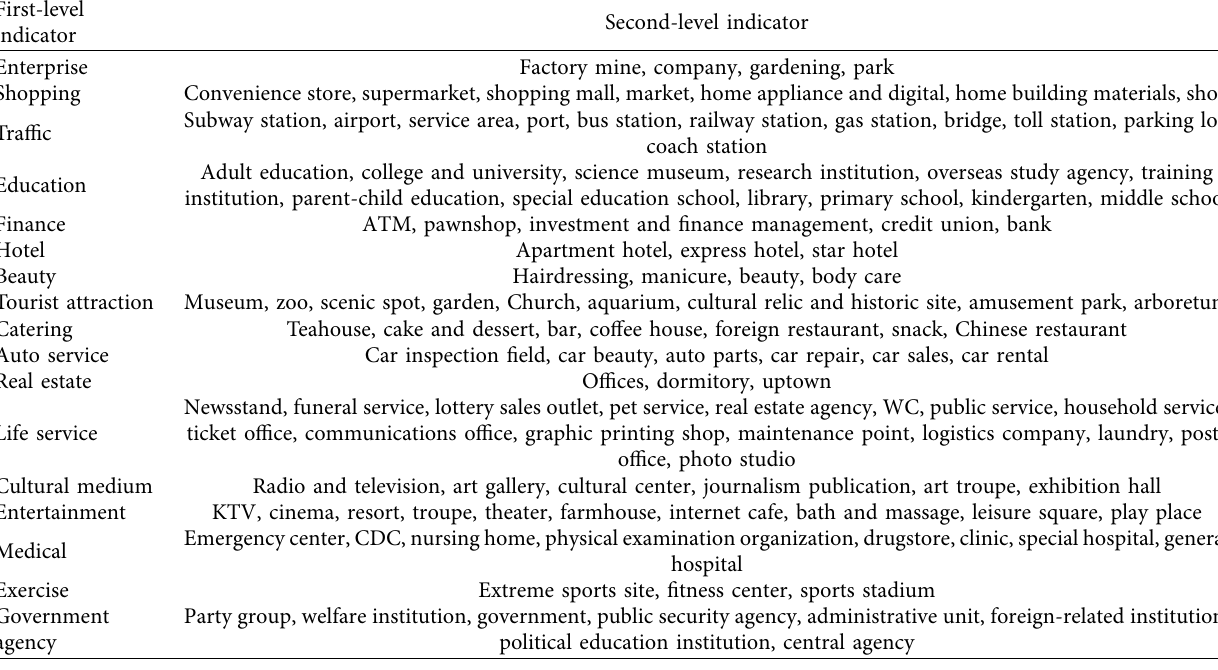
Table 3: Indicators of bicycle-sharing